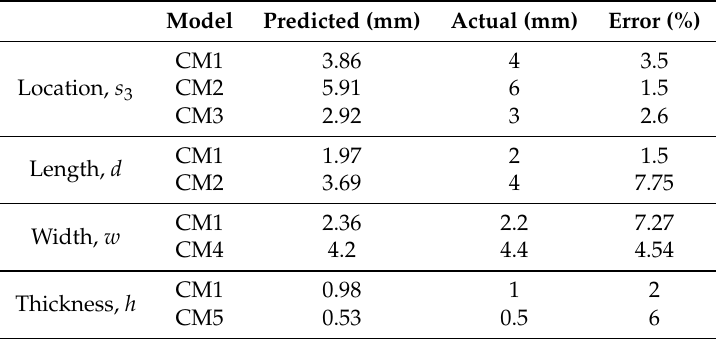
Table 4. Comparison between predicted and actual location and